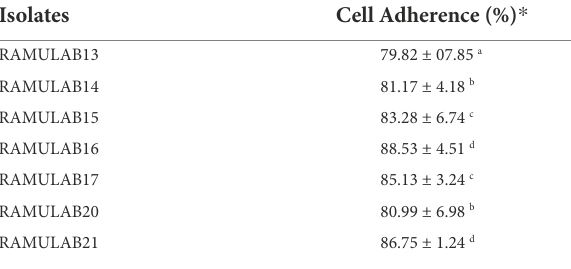
TABLE 3 Adhesion–measured by the percentage of isolates that adhere to HT-29 cells. Isolates